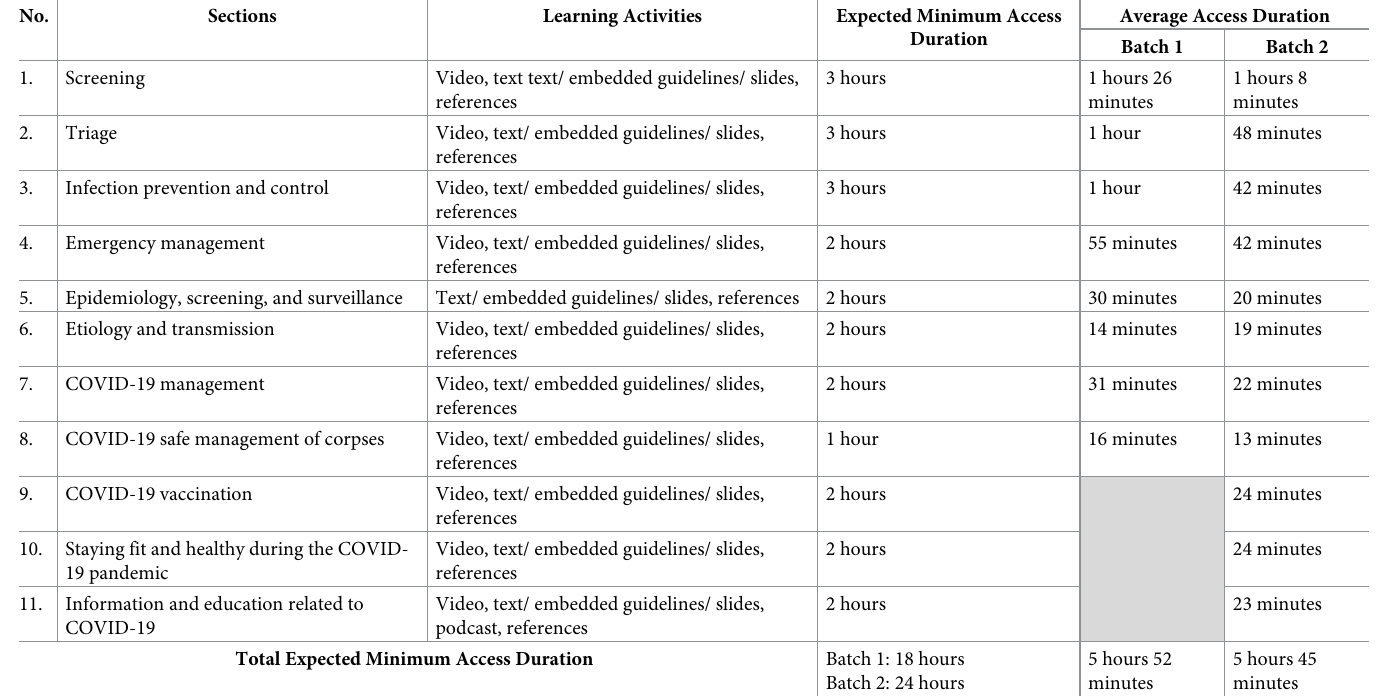
Table 1. Access duration in the sections of Part